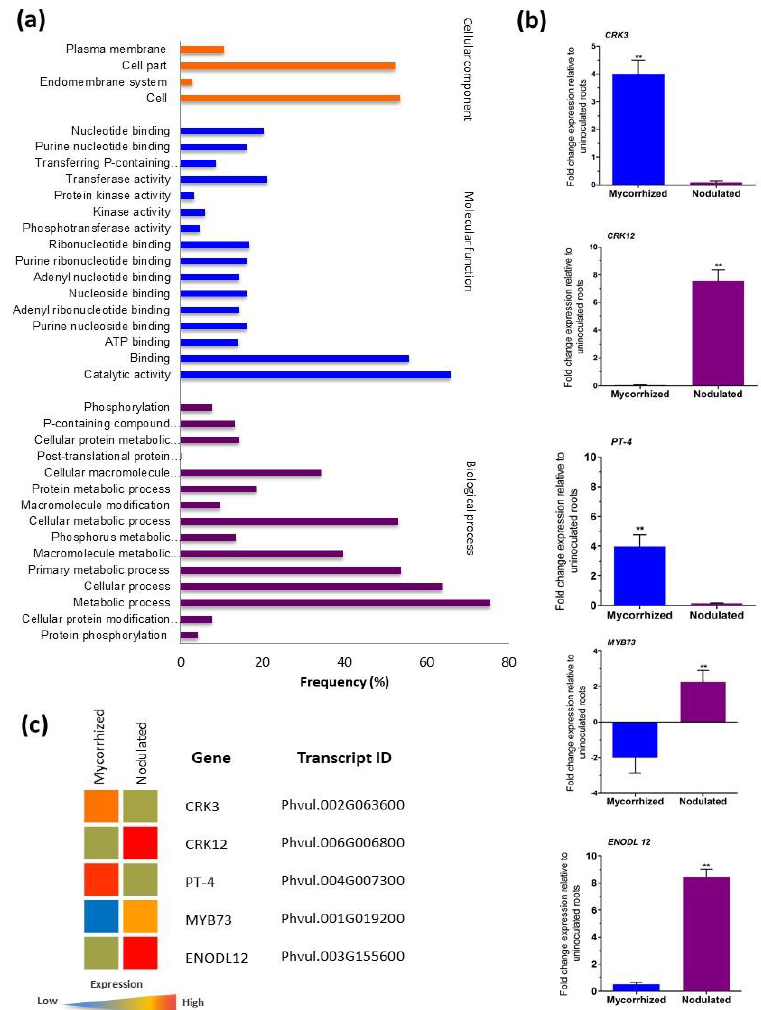
Figure 5. Gene ontology (GO) annotation and RT-qPCR validation of RNA sequencing (RNA-Seq) data from symbiont-colonized P. vulgaris roots. ( a ) GO term annotation of PvCRKs were summarized in three main GO categories, biological process, molecular function and cellular component. GO enrichment analysis performed using AgriGO and REVIGO platforms. Bars indicates the frequency of genes with the same term. ( b ) RT-qPCR analysis showing relative expression of Phaseolus CRK3 , CRK12 , PT-4 , MYB73, and ENODL12 genes. Candidate genes were selected and corresponding transcript accumulation under mycorrhized and nodulated conditions was quantified by RT-qPCR. RT-qPCR data are the averages of three biological replicates (n > 9). Statistical significance of differences between mycorrhized and nodulated roots was determined using an unpaired two-tailed Student’s t -test (** p < 0.01). Error bars represent means ± Standard error mean (SEM). ( c ) Heat map of the transcriptomic data obtained through RNA-Seq showing the expression profiles of CRK3 , CRK12 , PT-4 , MYB73 and ENODL12 . Color key in red and blue color represents upregulated and downregulated genes respectively whereas, yellow represents no transcript